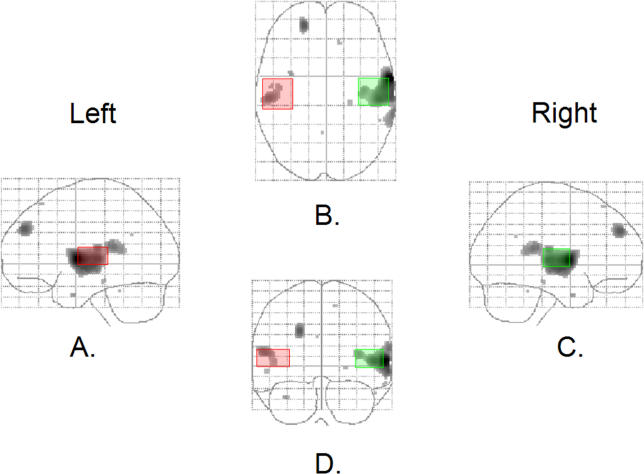
Auditory Cortical DeactivationAreas of significant deactivation in healthy volunteers (p < 0.001) during navigation are demonstrated in black on a glass-brain display. The probabilistic volume of A1 according to Penhune et al. [21] is outlined in green (right hemisphere) and red (left hemisphere). Aspects are (A) left lateral, (B) cranial, (C) right lateral, and (D) dorsal.